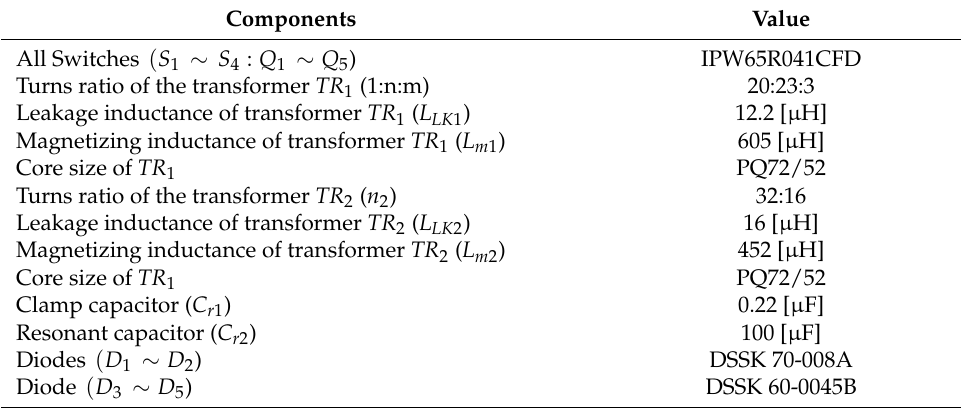
Table 2. Parameters of the circuit components.